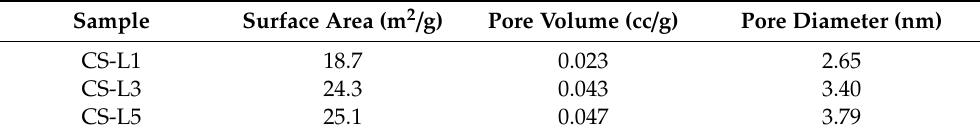
Table 2. BET surface area, cumulative pore volume and pore diameter of CS membranes.